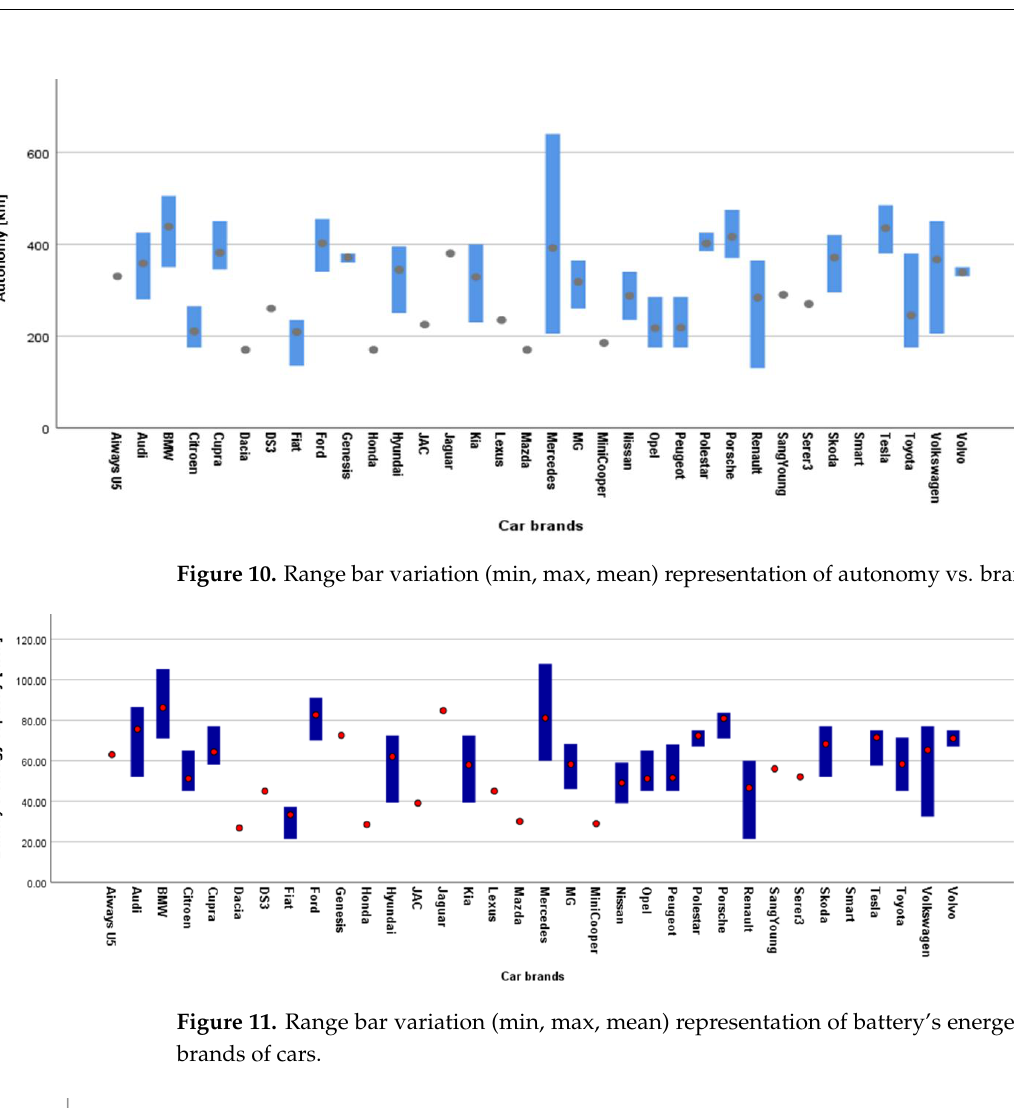
Figure 9. Range bar variation (min, max, mean) representation of vehicle weight vs. year of availa-